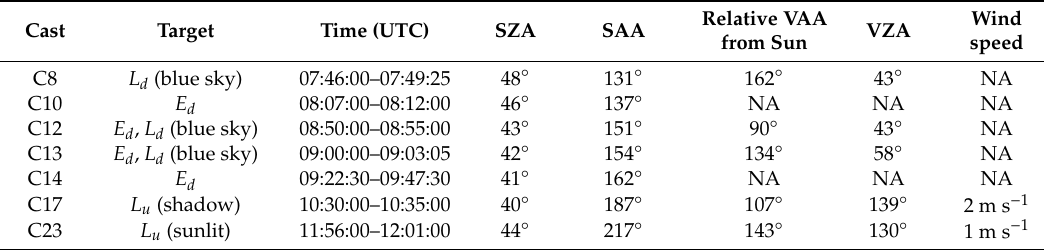
Table 3. Casts used in the analysis.